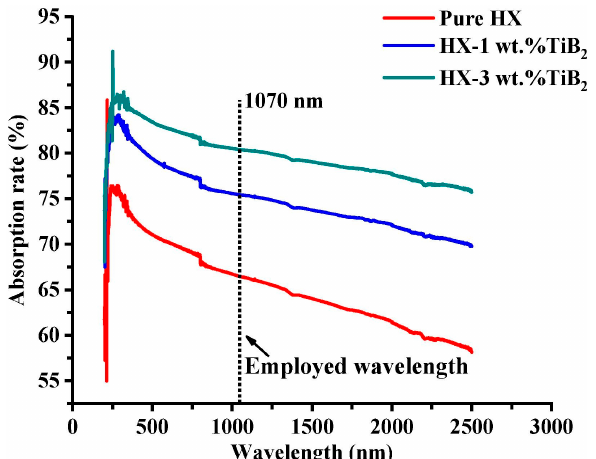
Figure 4. TEM image of dislocations around TiC particles [62].